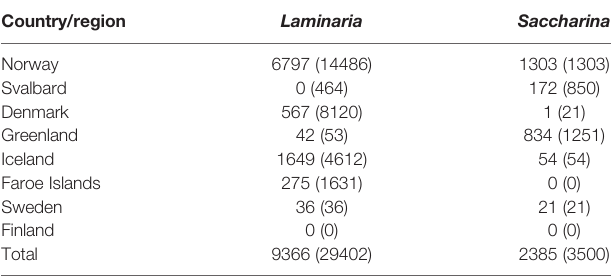
TABLE 1 | Predicted kelp forest area (km 2 ) of the genera Laminaria and Saccharina per Nordic country or region.